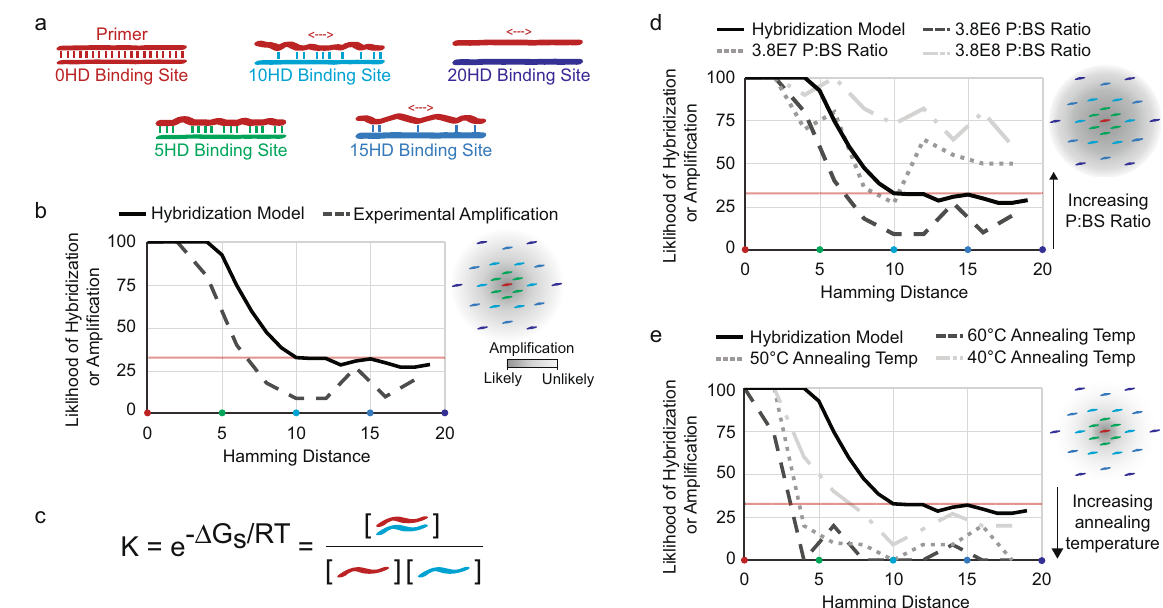
Fig. 1 Stringency of PCR reactions is tunable via annealing temperature and primer concentration. a File address sequence similarity is inversely proportional to Hamming distance (HD — total number of nucleotide differences in a given sequence). While perfectly matching (0 HD) primers tightly bind their complementary binding sequence, primers with increasing HDs can still bind with a gradually diminishing effect. b A thermodynamic model shows that the likelihood of hybridization (black trace) reaches a plateau (red line) around 10 HD and remains level out to 20 HD. Likelihood of ampli fi cation (gray dashed line) is represented as a percent of the ten sequences experimentally tested at each HD (0, 2, 4, 6, 8, 10, 12, 14, 16, 18, 20) that created PCR product. b , d , e , spherical insets: Visualization of address space with a perfect primer-address match at the center in red. DNA storage systems currently implement addresses that are at least 10 HD (light blue strands) apart. This disregards and wastes much of the potential address space (i.e., green strands). Gray shading indicates the likelihood of hybridization/ampli fi cation with a red primer. c The equilibrium constant of thermodynamically controlled interactions can be computed based on the sequences ’ Gibbs Free energy ( Δ G), the gas constant (R), and the PCR annealing temperature ( T ). Annealing temperature and primer concentration impact the amount of template ampli fi ed via PCR. d Primer concentration, represented by the primer to binding site (P:BS) ratio, is experimentally varied at a constant 50 °C annealing temperature. The likelihood of nonspeci fi c ampli fi cation increases with increasing P:BS ratio. e The annealing temperature is experimentally varied at a constant 1.9E7 P:BS ratio. The likelihood of nonspeci fi c ampli fi cation decreases with increasing annealing temperature. Source data are provided as a Source Data fi